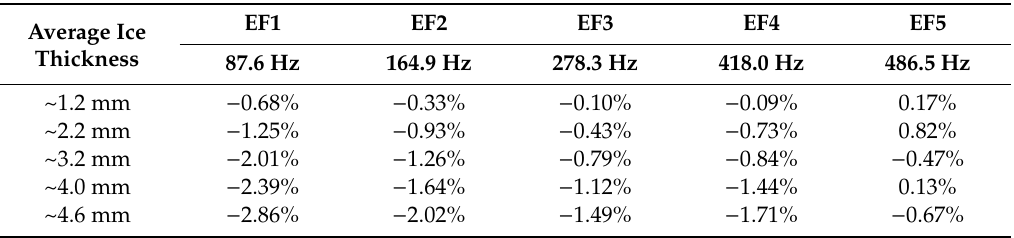
Table 4. Relative shift of the first five natural frequencies under ice accumulation at approximately − 17 °C.